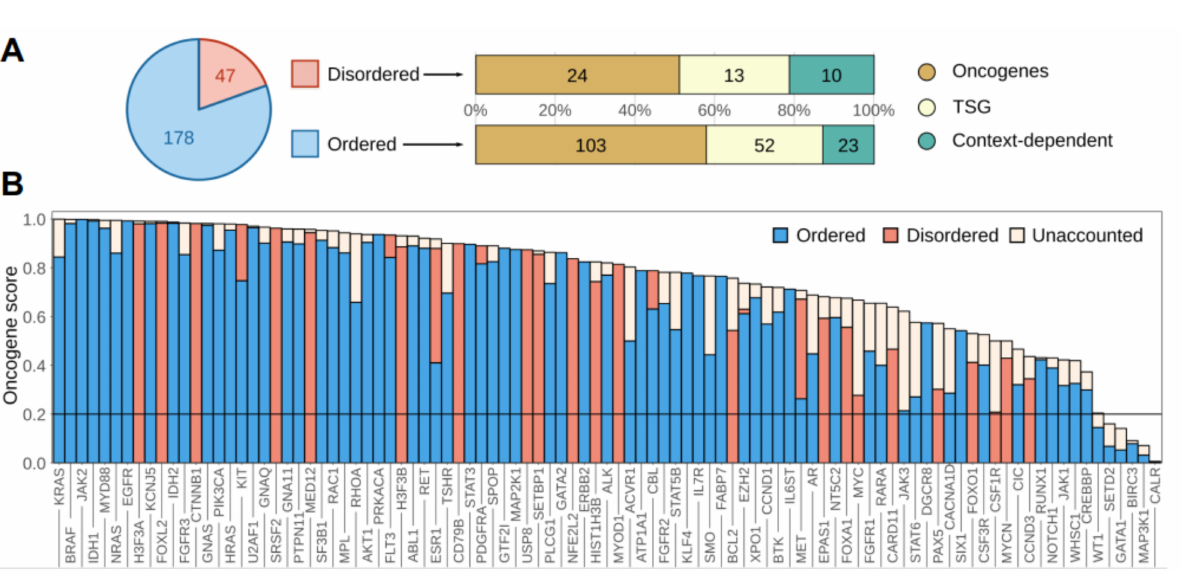
Figure 1. The distribution of ordered and disordered driver protein regions. ( A ) The distribution of ordered and disordered driver protein regions and their distribution among oncogenes, tumor suppressor genes (TSG) and context-dependent genes. ( B ) Oncogene scores of full genes and oncogene scores explained by the identified regions in oncogenes and context-dependent driver genes. “Unaccounted” corresponds to the fraction of mutations not in the identified, high significance